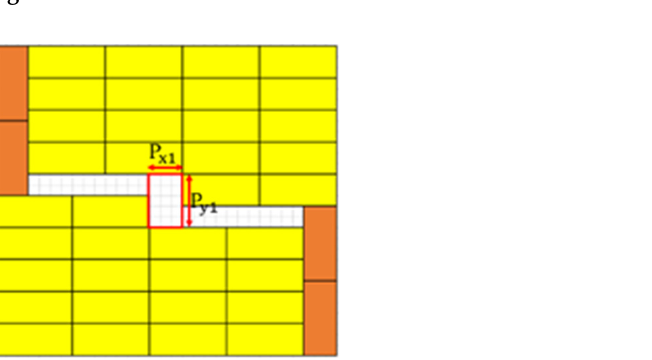
Figure 12. The area after calculation when Block 2 and Block 4 are non-overlapped.